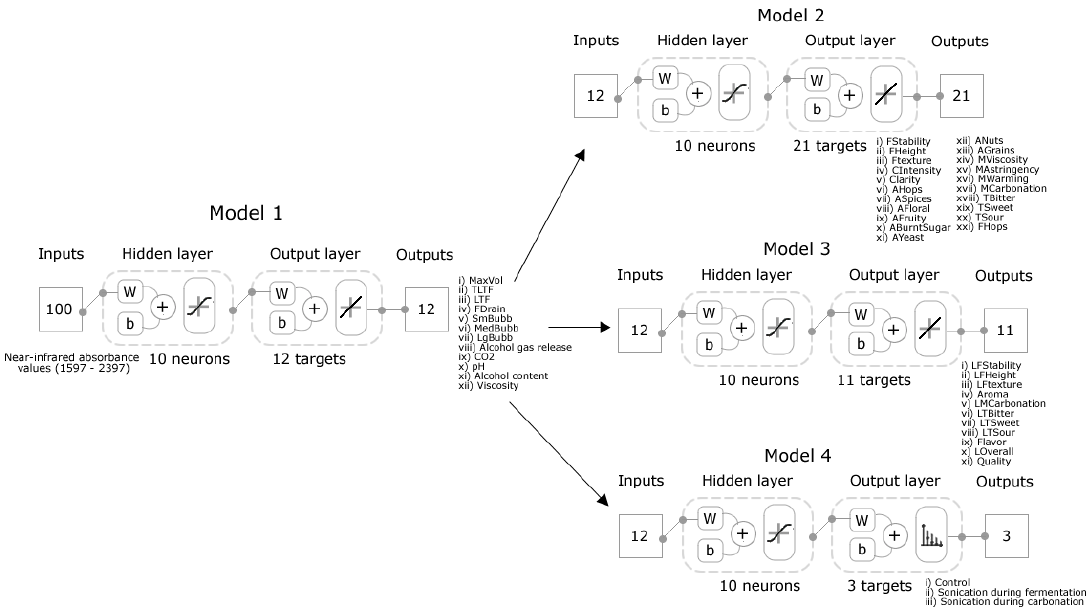
Figure 2. Diagram showing the artificial neural network (ANN) two-layer feedforward models. Models 1–3 consist of ANN regression with the tan-sigmoid function in the hidden layer and linear transfer function in the output layer. Model 4 consists of ANN pattern recognition with the tan- sigmoid function in the hidden layer and Softmax transfer function in the output layer. Abbreviations: W: weights, and b = bias, inputs, outputs/targets abbreviations are found in Tables 2, 3, and